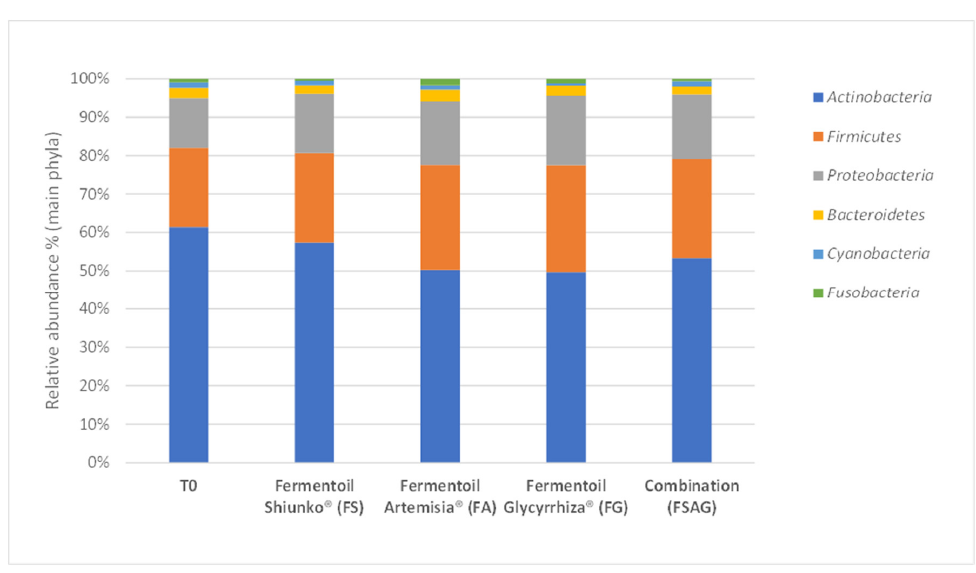
Figure 2. Semi-quantitative bacterial composition: relative abundance at phylum level. (a) T0; (b) F-Shiunko (FS) at T1; (c) F-Artemisia (FA) at T1; (d) F-Glycyrrhiza (FG) at T1; (e) combination (FSAG) at T1.